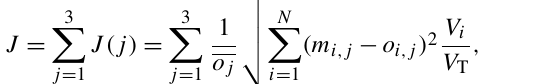
) for optimisation in square brackets; n/a: not applicable for (cid:50)